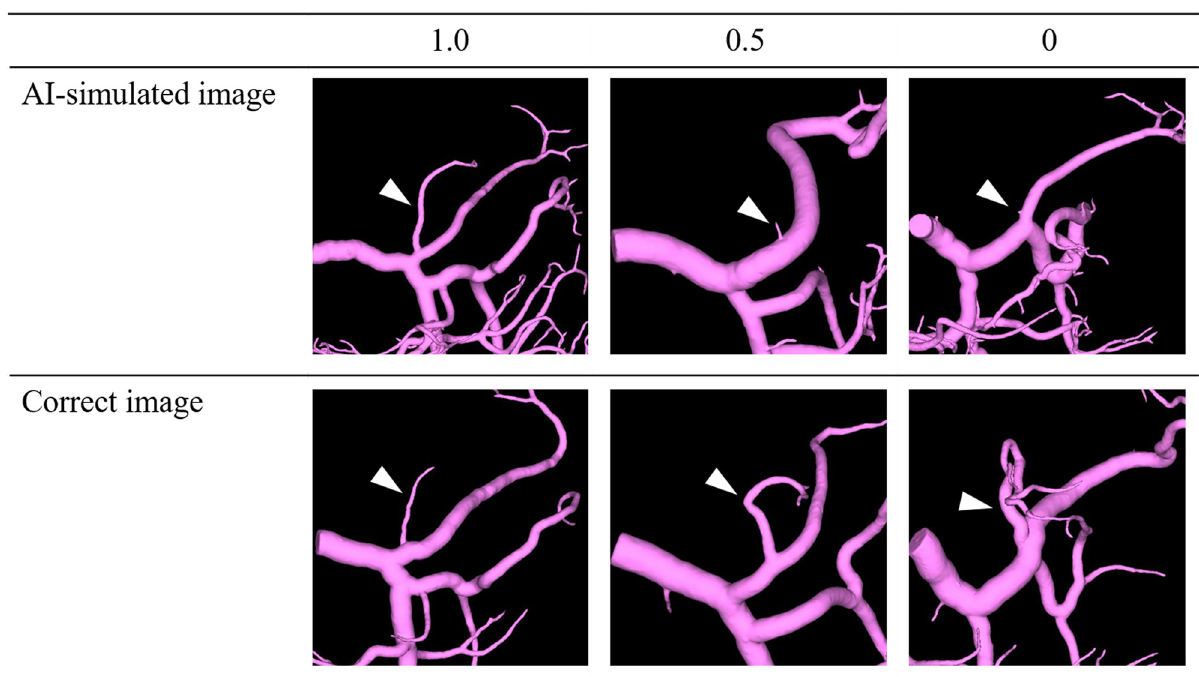
Fig 1. Three-stage visual evaluation of the images by a senior pancreatic surgeon. For arteries and portal veins/veins, sensitivity and specificity were calculated along with the Dice coefficient, in addition to visual evaluation of the images by a surgeon (three-stage evaluation). For visual evaluation, the sensitivity of the pancreatic surgeon in identifying each blood vessel was defined as 1.0 if the area required for the preoperative simulation could be extracted, 0.5 if there was any interruption or only the branch could be extracted, and 0.0 otherwise.